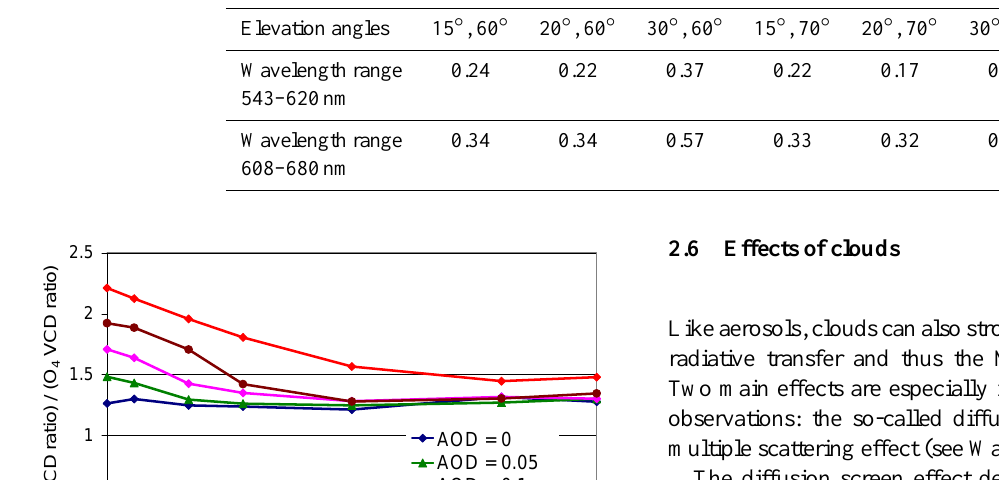
Table 2. Standard deviation of the O 4 VCD relative to the average O 4 VCD (in %) derived from different combinations of elevation angles and wavelength ranges for the whole campaign.